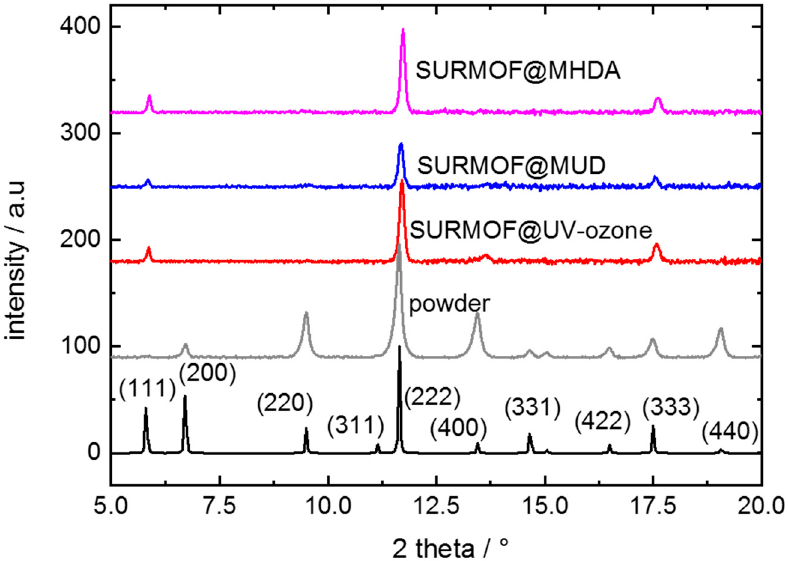
Figure A7. Out-of-plane XRD of HKUST-1 samples. The XRD of the MOF powder (for Figure 3b) is shown in grey. The XRDs of the SURMOFs grown on substrates with MHDA, MUD, and UV-ozone functionalization (see labels, for Figure 5) are shown in magenta, blue, and red, respectively. The black line is the calculated diffractogram with the labelled diffraction peaks. While the MOF powder shows all diffraction peaks, the SURMOF samples are grown in (111) orientation, showing only the ( nnn ) XRD peaks.